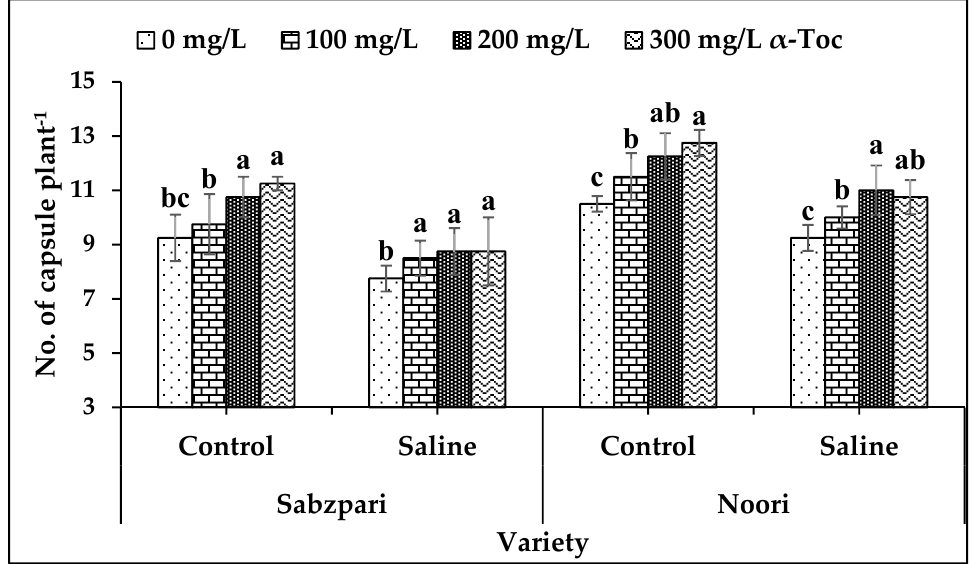
Figure 7. Effect of different levels of α -Toc under saline and non-saline conditions on number of capsule Plant -1 of okra varieties. Values represent means ± S.D. Significant differences among row spacing were measured by the least significant difference (LSD) at p > 0.05 and indicated by different letters. S.D. stands for standard deviation